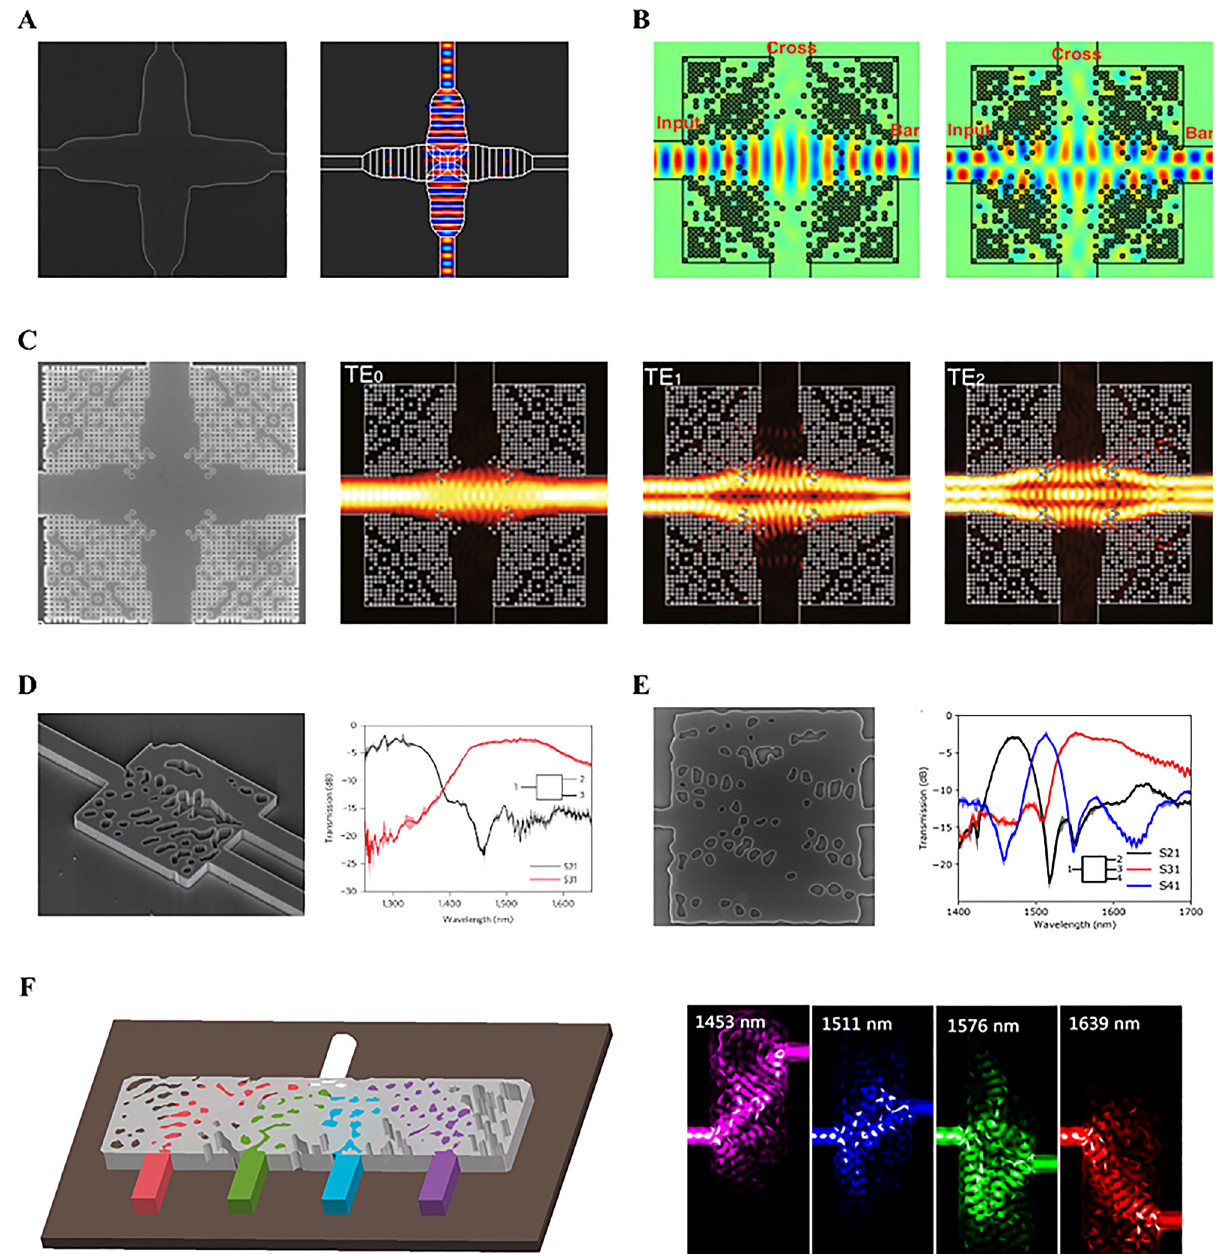
Figure 6: Diagram of the development of inverse-designed devices from single-mode (two-channel) to multi-mode (multi-channel) devices. (A) Inverse-designed single-mode waveguide crossing. Left: SEM image of the fabricated waveguide crossing structure. Right: electric field distribution of the device. Reproduced with permission [127]. Copyright 2009, Optical Society of America. (B) Inverse-designed dual-mode waveguidecrossing. Left: Simulatedmagnetic fi eld distributions of H z for the TE 0 mode. Right: Simulatedmagnetic fi eld distributions of H z for the TE 1 Mode. Reproduced with permission [131]. Copyright 2018, Optical Society of America. (C) Inverse-designed three-mode waveguide crossing. Left: SEM image of the fabricated crossing. Right: Simulated optical fi eld distributions for the TE 0 , TE 1 and TE 2 modes. Reproduced withpermission[20].Copyright2019,NaturePublishingGroup.(D)Inverse-designedtwo-channelwavelengthdemultiplexer.Left:SEMimage ofthefabricateddemultiplexer.Right:Measured S -parametersforthreeidenticaldemultiplexers.Reproducedwithpermission[18].Copyright 2015, Nature Publishing Group. (E) Inverse-designed three-channel wavelength demultiplexer. Left: SEM image of the fabricated demultiplexer.Right:Measured S -parametersforfouridenticaldevices.Reproducedwithpermission[87].Copyright2017,AmericanChemical Society. (F) Inverse-designed tuneable four-channel wavelength demultiplexer. Left: Three-dimensional diagram of the designed demultiplexer. Right: Simulated electromagnetic energy distribution for different wavelengths. Reproduced with permission [89]. Copyright 2020, Elsevier